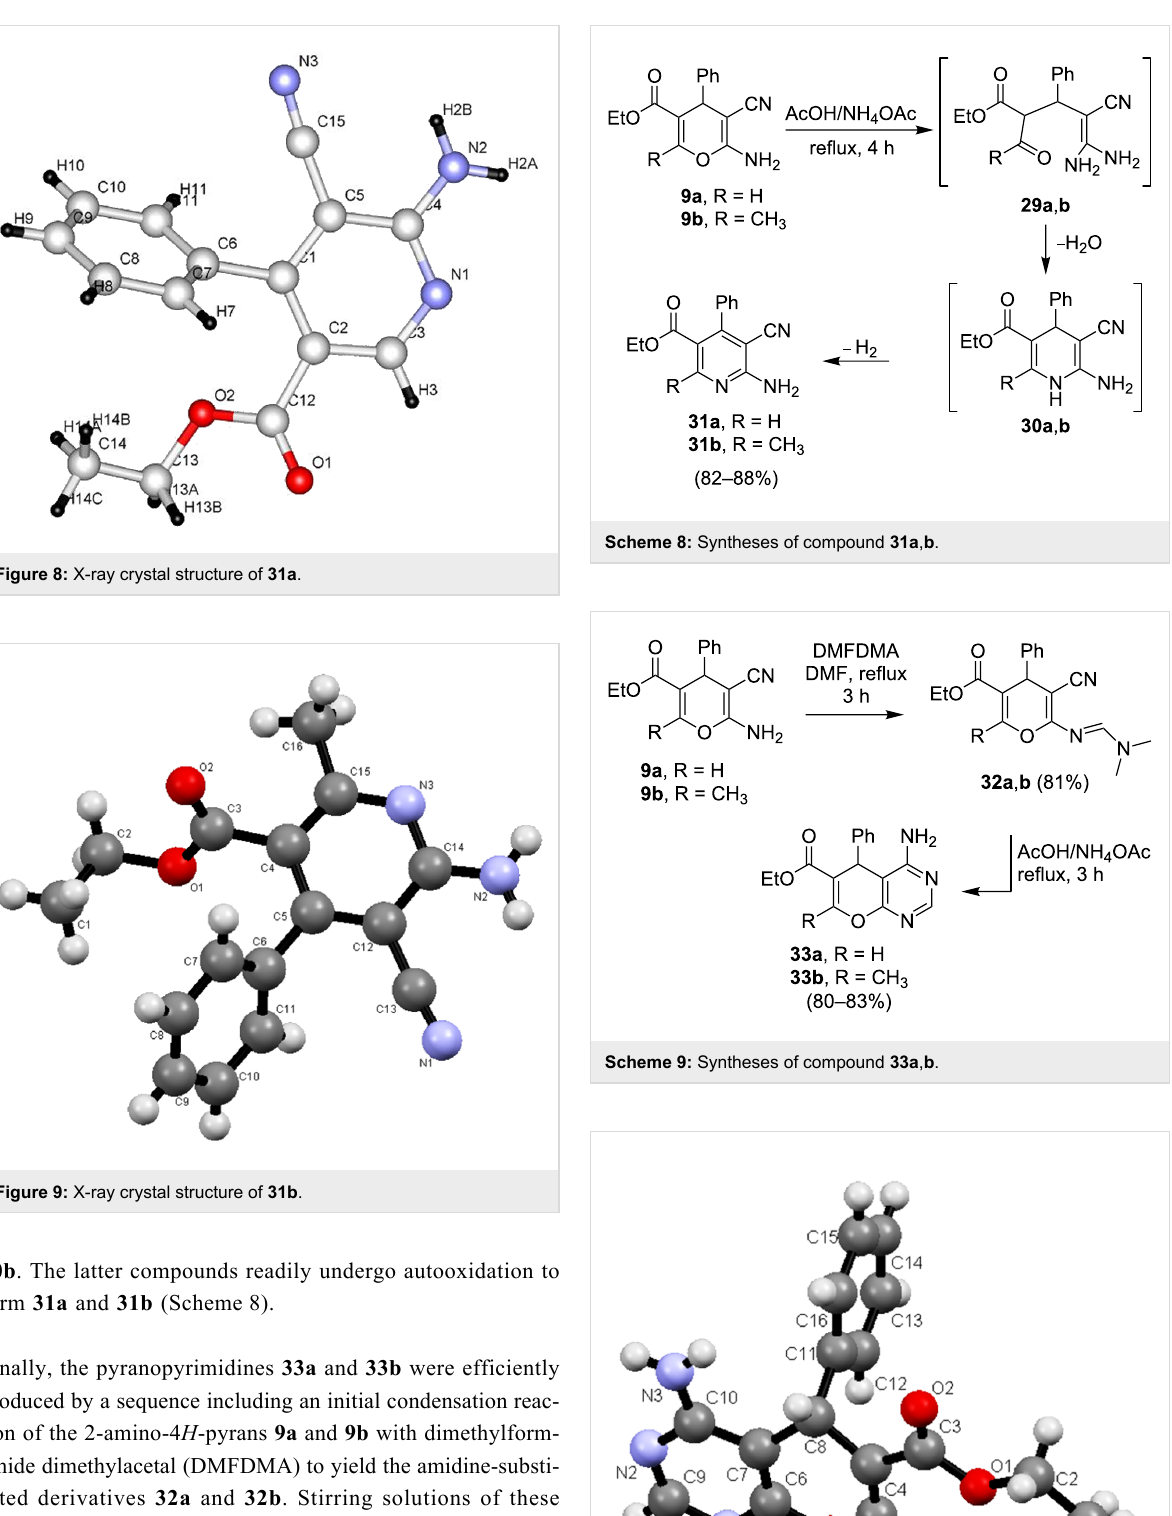
30b . The latter compounds readily undergo autooxidation to form 31a and 31b (Scheme 8).